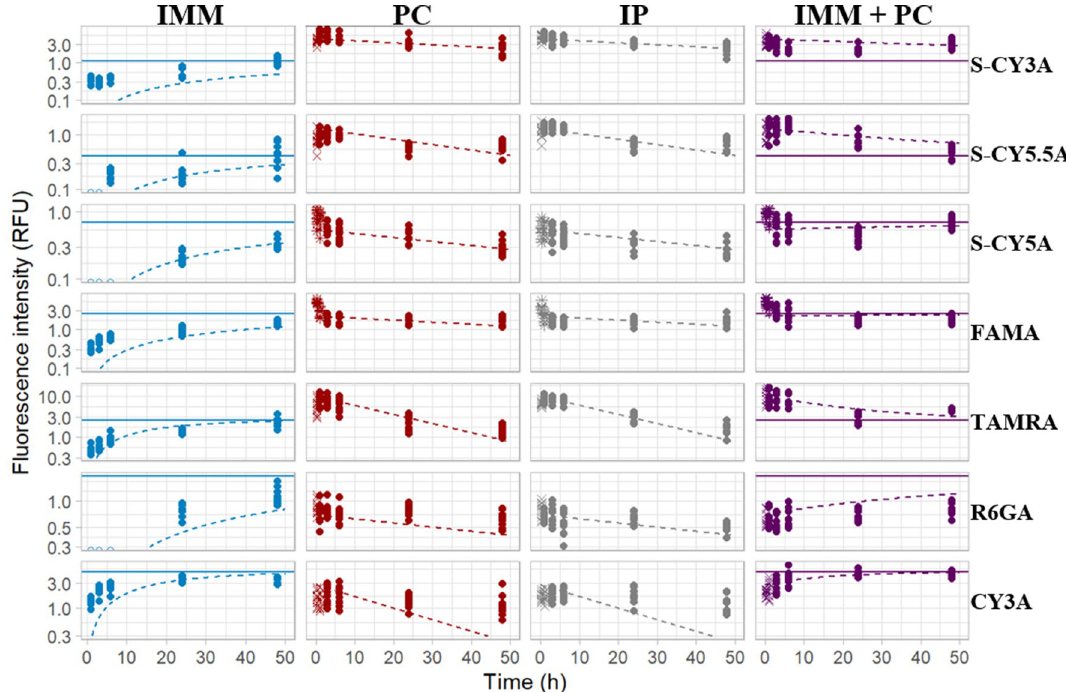
Figure 9. Fluorescence-time curves for all compounds and administration routes, with excluded data points marked as X symbols. Model prediction is presented as dotted line, model-predicted equilibrium fluorescence after immersion as solid horizontal line. The image was produced using R (version 4.0.3 https:// www.r- proje ct. org/ 2020) and colours arranged in GIMP (version 2.10.24 https:// www. gimp. org/ 2021) Software.